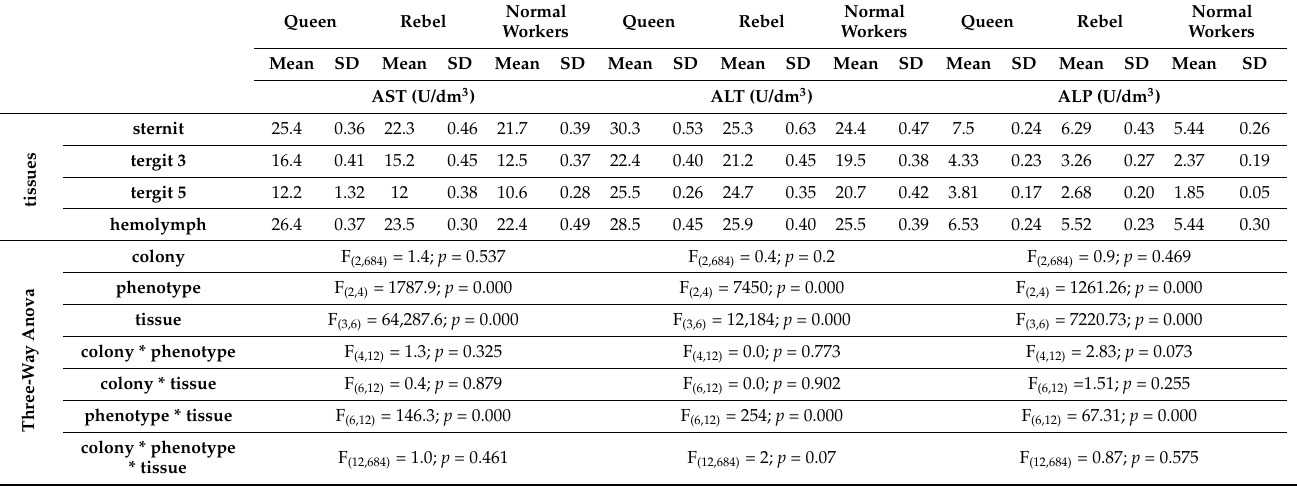
Figure 1. Phenoloxidase activities in the hemolymph of the A. mellifera queens, rebels, and normal (sterile non-rebel) workers. Lowercase letters indicate significant differences between phenotypes (queen/rebel/normal worker) with p < 0.05. Table 3. Activities of biomarkers in the fat body and hemolymph of the A. mellifera queens, rebels, and normal (sterile non-rebel) workers.